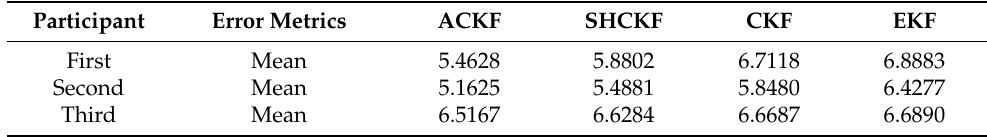
Table 3. Comparisons of the mean absolute error (MAE) of heading